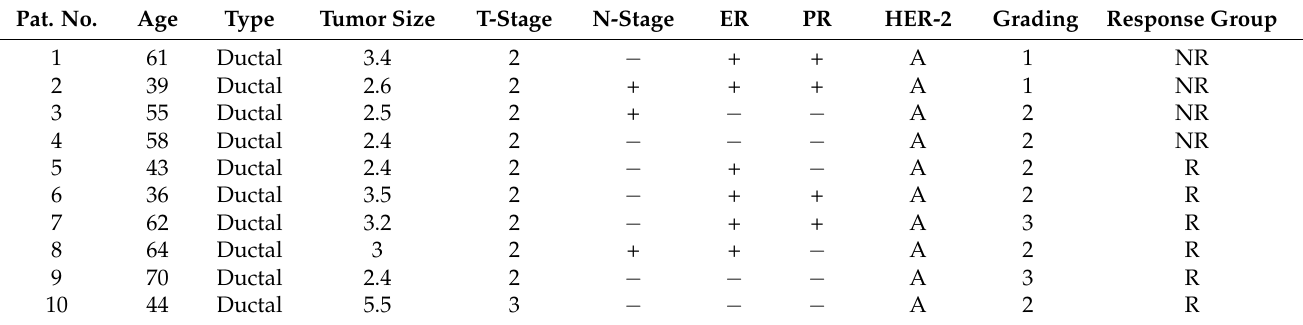
Table 1. Clinical characteristics of the patient study